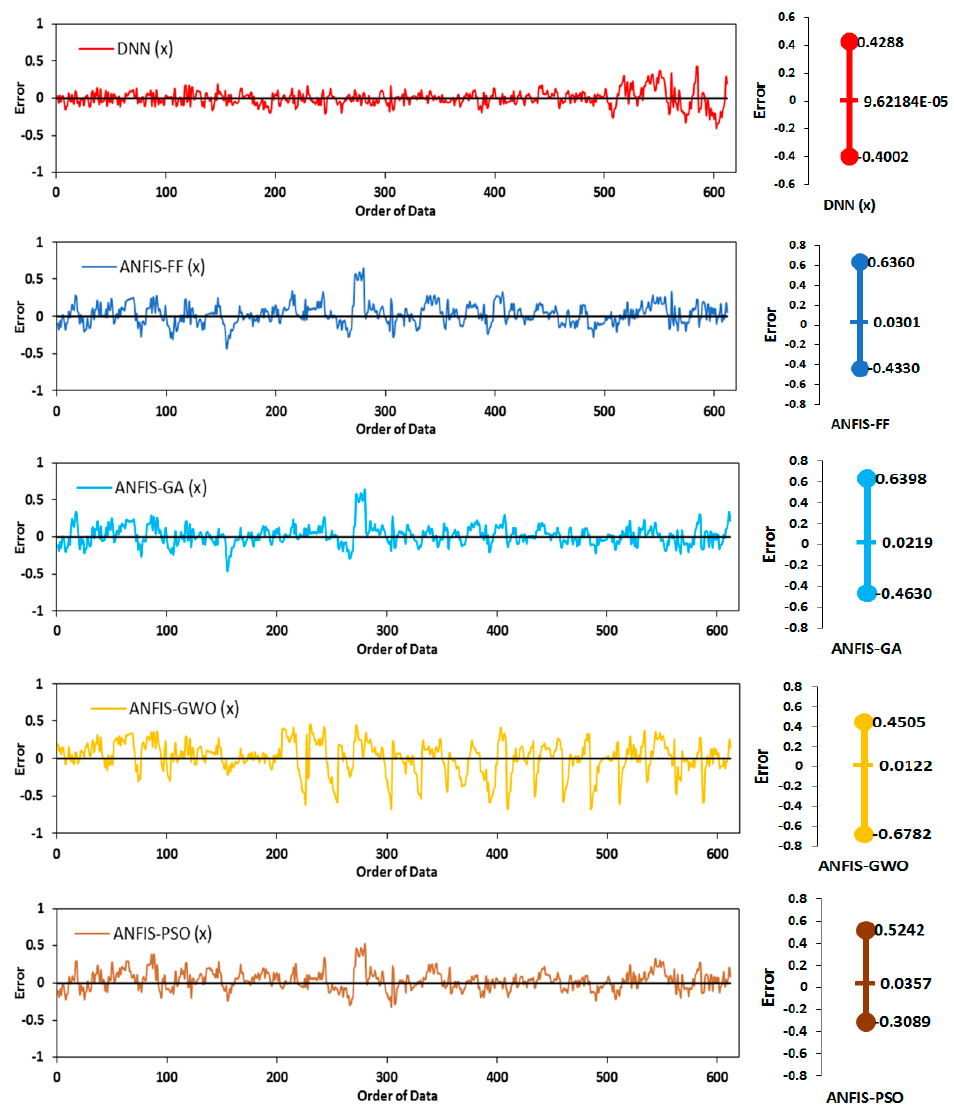
Figure 12. Error diagram in x direction.